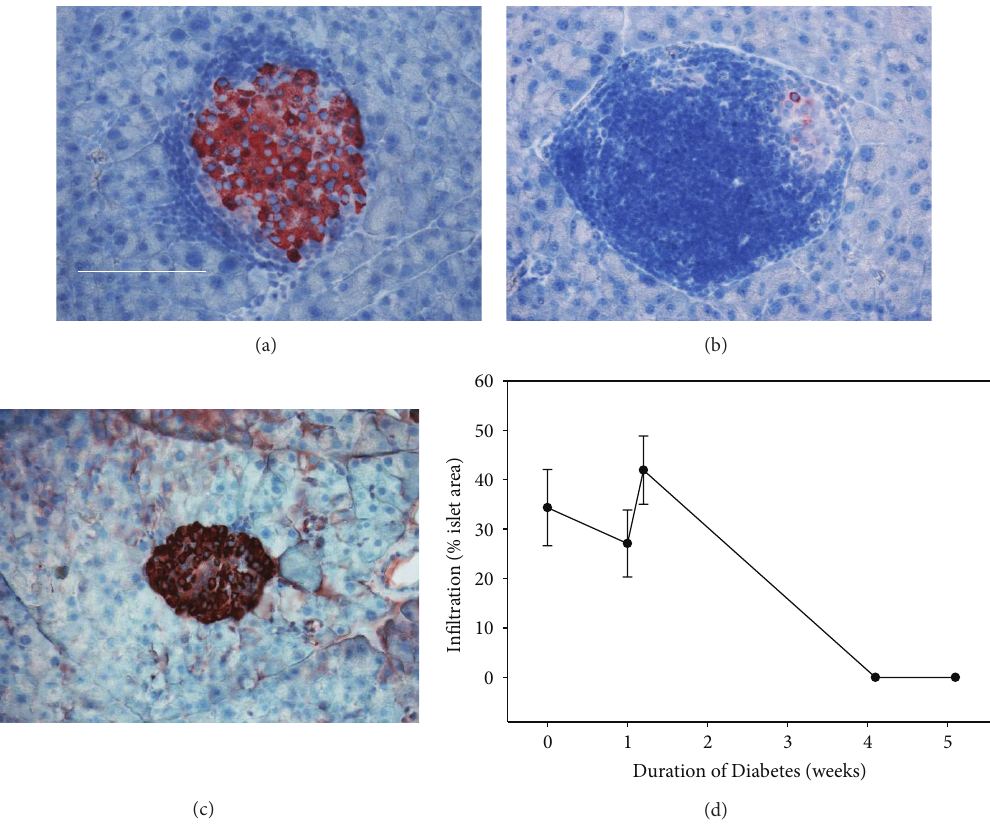
Figure 6: Lymphocyte infiltration in NOD mice. Staining of 𝛽 -cells with anti-insulin antibodies, counter-stained with hematoxylin, revealed different levels of immune cell infiltration in mice that failed to develop diabetes, ranging from little infiltration (a) to complete penetration (b). The infiltrates are identified by a high density of blue nuclei surrounding the 𝛽 -cells (red). Scale bar = 50 𝜇 m for all images. (c) There was no infiltration noted at the late stages of diabetes. These sections had to be stained with antiglucagon rather than anti-insulin, because there were no insulin-positive cells at later time points. (d) A plot of the amount of infiltration per duration of diabetes summarizes the findings ( 𝑁 = 65 islets from 6